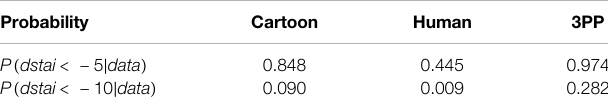
TABLE 5 | Posterior probabilities of the change in dstai being less than − 5 or − 10 at the mean level of staitrait.